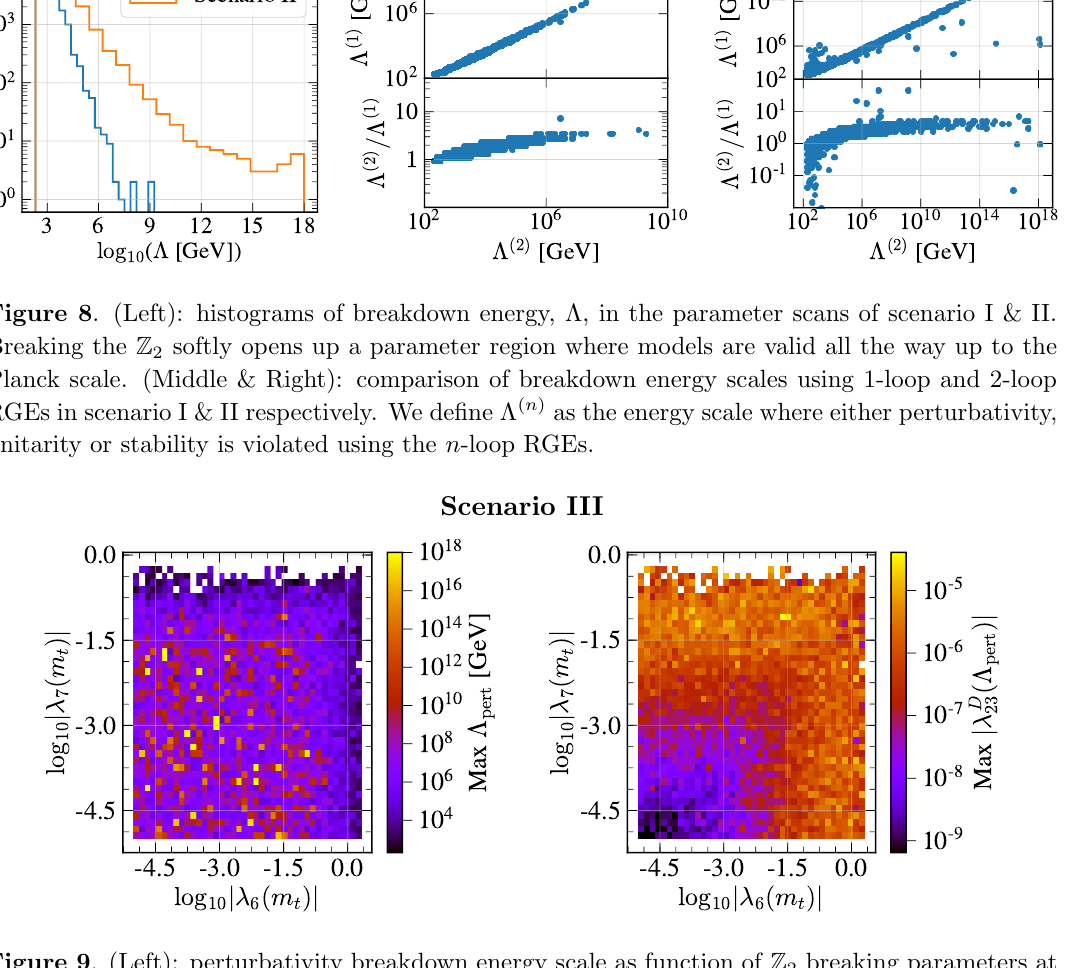
p = (cid:26) D v 2 = (2 m s m b 23 23